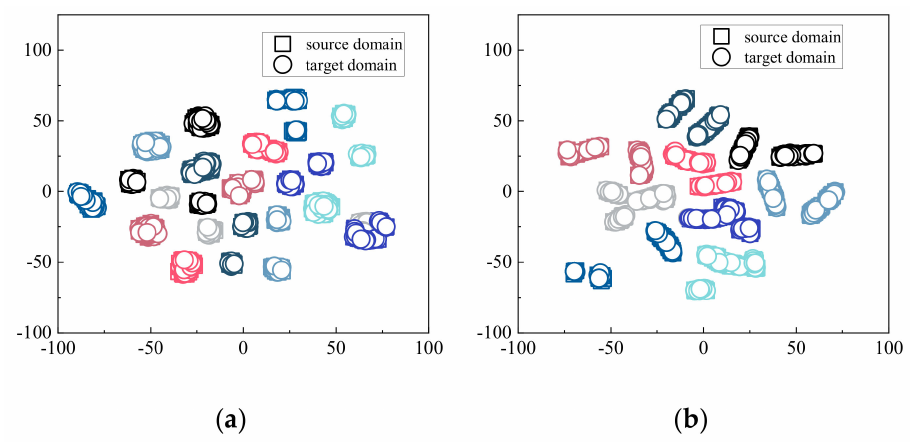
Figure 28. T − SNE visualization of fault features: ( a ) original signal; ( b ) feature embedding derived from DANN. Squares represent the source domain and circles represent the target domain. Color represents different fault